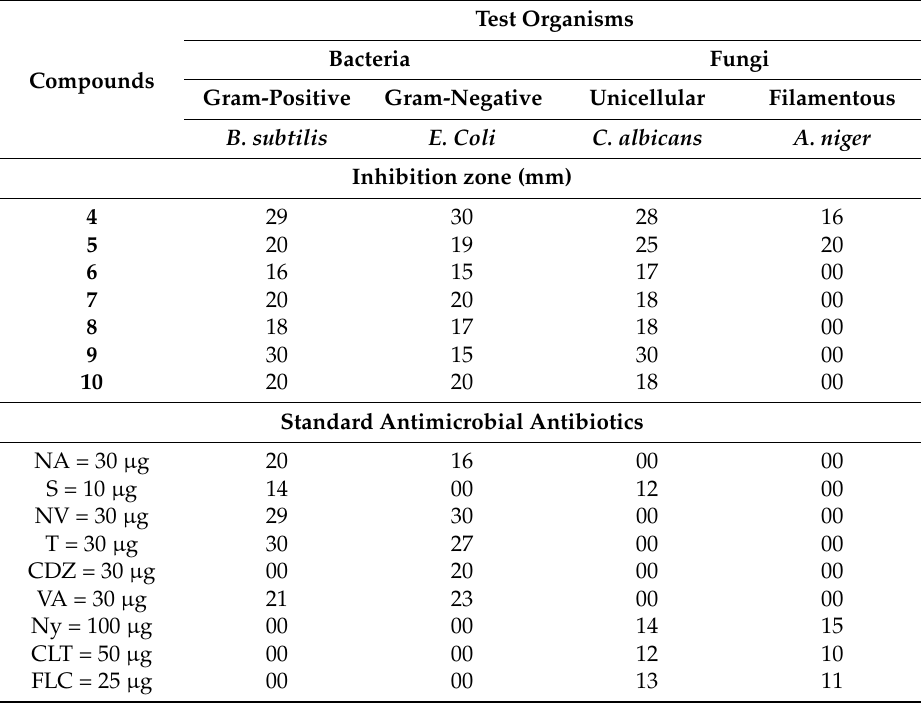
Table 1. The antimicrobial activities of the synthesized candidates expressed as inhibition zones of growth in millimeters against the used test